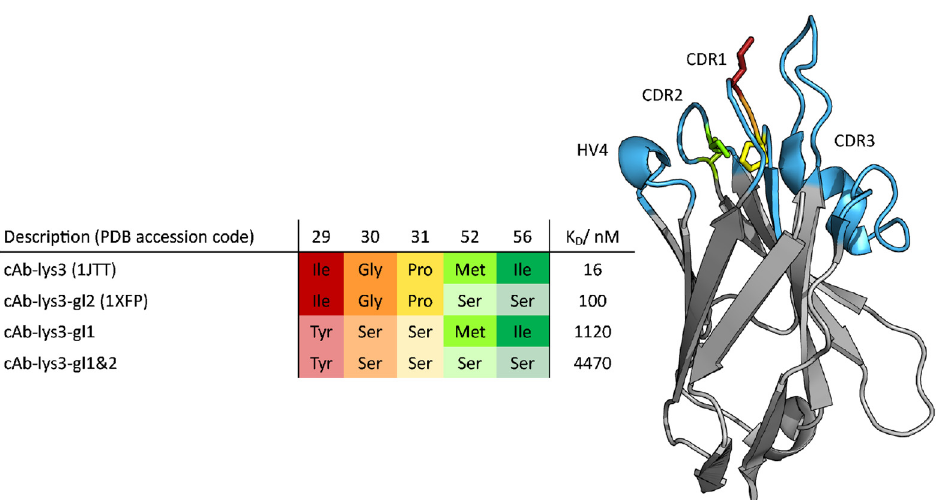
Figure 2. Tabular overview of the introduced point mutations ( left ). The introduced point mutations and respective positions are color-coded and shown as sticks for the cAB-lys3-gl2 (PDB: 1XFP) ( right ). The CDR loop regions CDR1, CDR2, CDR3 and the hypervariable region HV4 are highlighted in light blue and labeled.